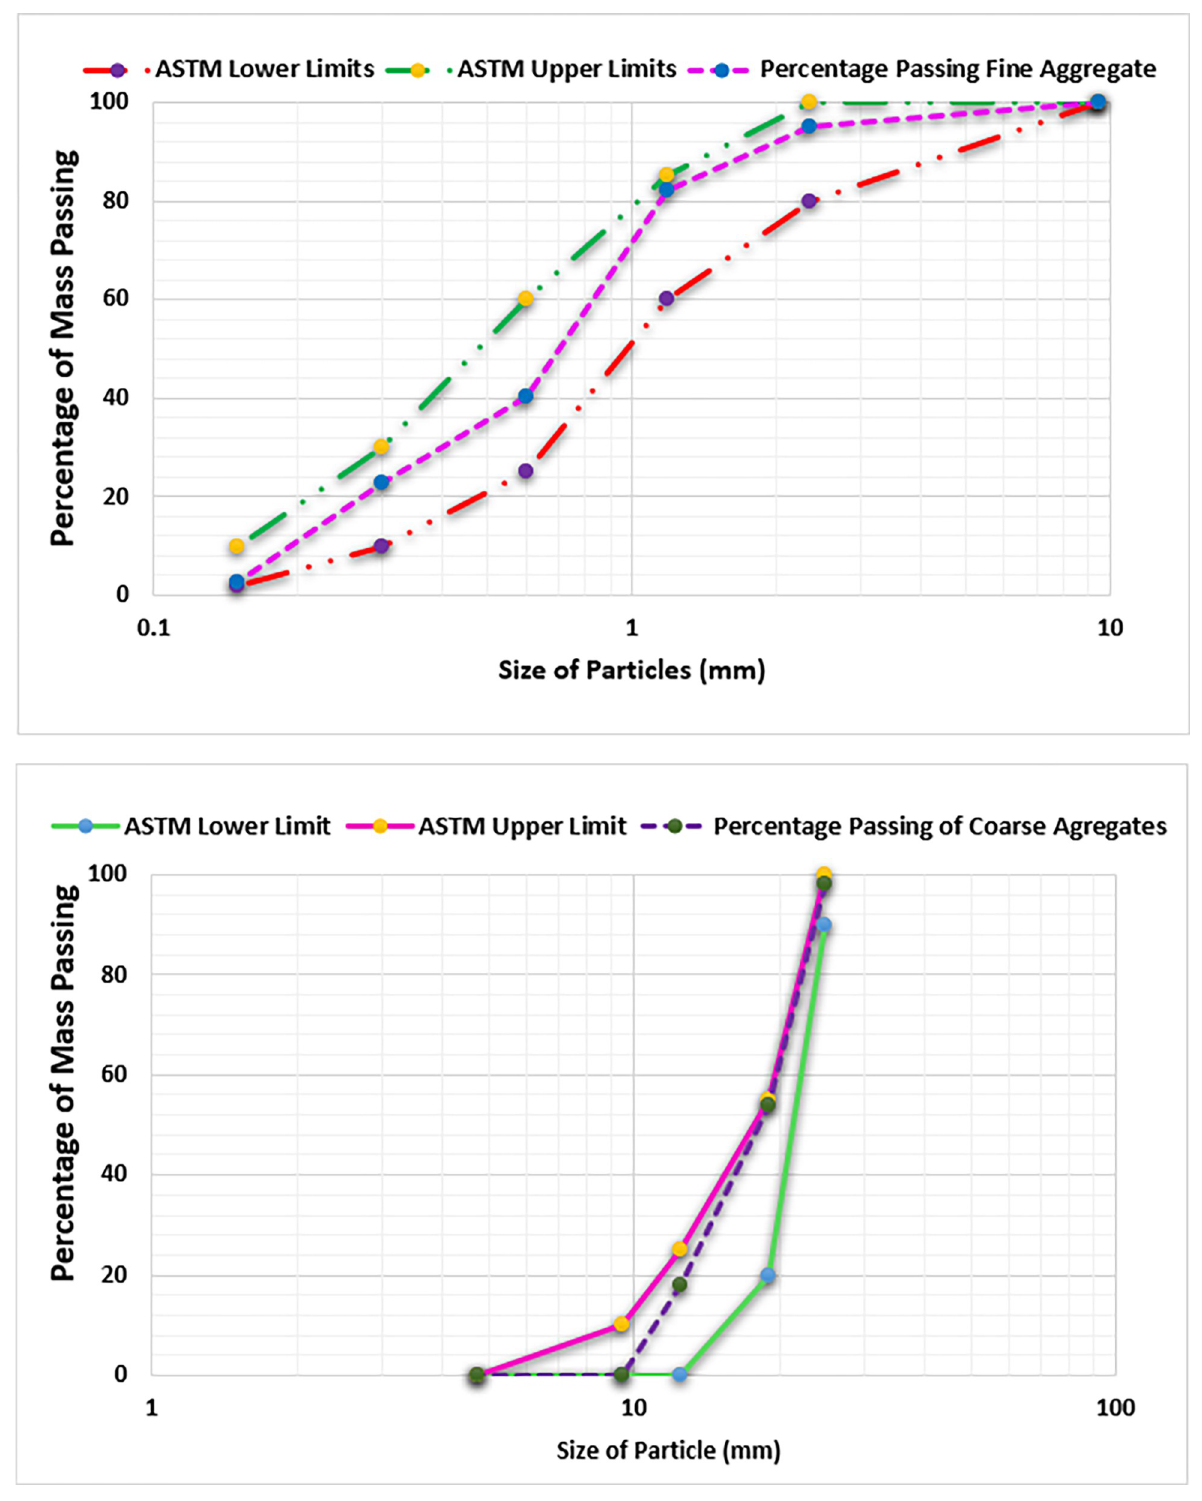
Fig 3. Particle Size Distribution; (a) Fine aggregates, (b) Coarse aggregates.